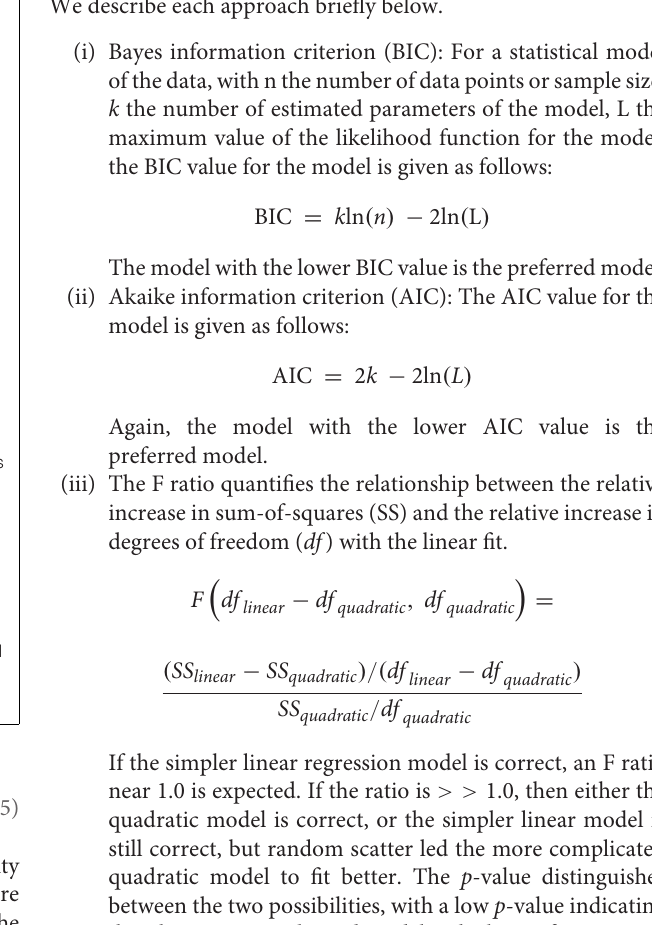
in mutual information. Details are provided in Rigau et al. (2005) and Sbert et al.